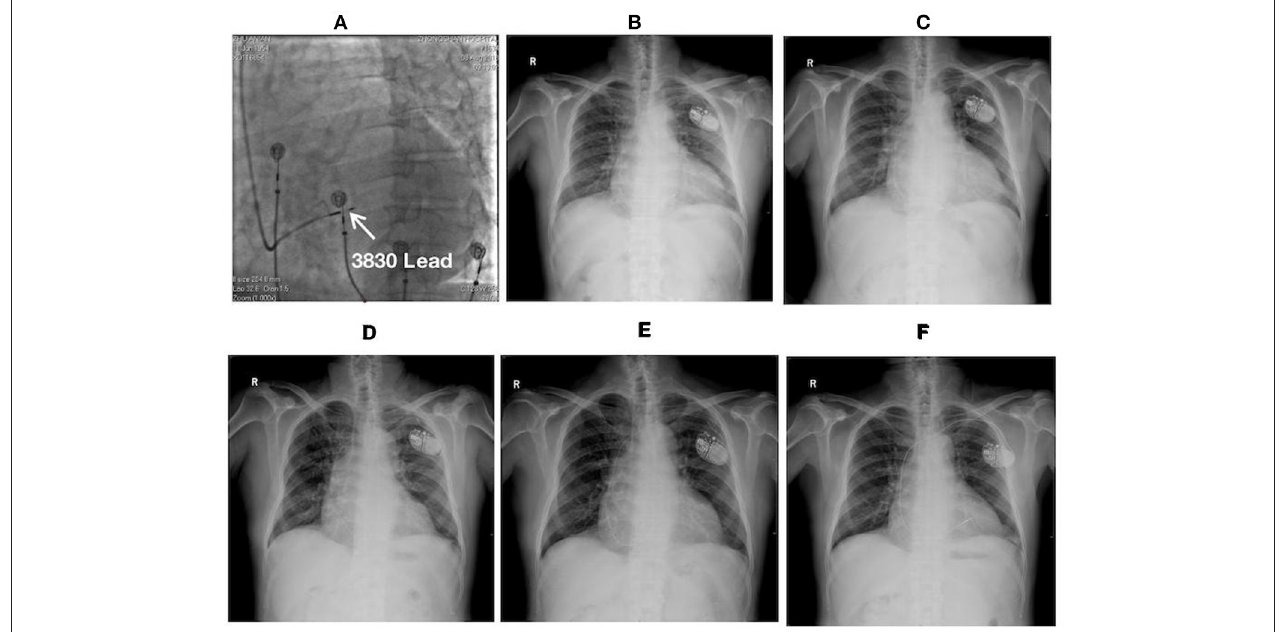
FIGURE 4 | Fluoroscopic images of a 64-year-old male with LBBP lead dislodgement: (A) The fluoroscopic image at LAO 30 ◦ during the procedure illustrating the lead depth inside the septum (white arrow); (B) Postoperative X-ray film; (C) X-ray film at the 1-month postoperative follow-up illustrating lead dislodgement; (D) X-ray film after lead reposition; (E) X-ray film at 5 months after lead reposition demonstrating the recurrence of lead dislodgement; (F) X-ray film on the 2nd day after the 2nd lead repositioning demonstrating the repositioning of a new lead (Model 5076, Medtronic Inc., Minneapolis, MN, USA) at the RV septum. LAO, left anterior